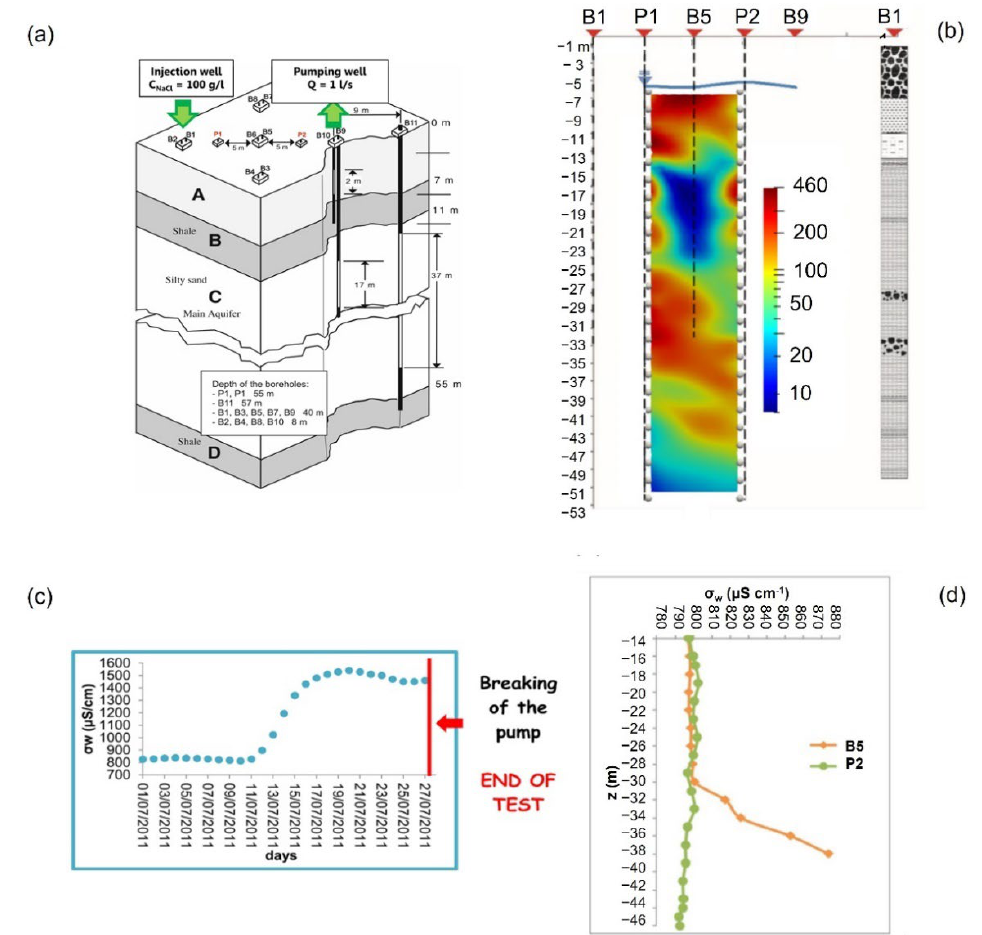
Figure 3. ( a ) Tracer test at Montalto Uffugo test site: (Formation A) shallow aquifer; (Formation B) shale; (Formation C) main aquifer, silty sands alternated to conglomerate and clay lenses; (For- mation D) shale. B1–11 are boreholes. P1–2 are piezometers for CH-ERT. ( b ) Pre-tracer test resistivity model and B11 stratigraphic log (from 41, modified); ( c ) water electrical conductivity (normalized at 20 ◦ C) monitored in P1 at the depth of 40 m; ( d ) water electrical conductivity (normalized at 20 ◦ C) logs measured 20 days after the salt injection (19 July), in boreholes B5 and P2. Adapted from